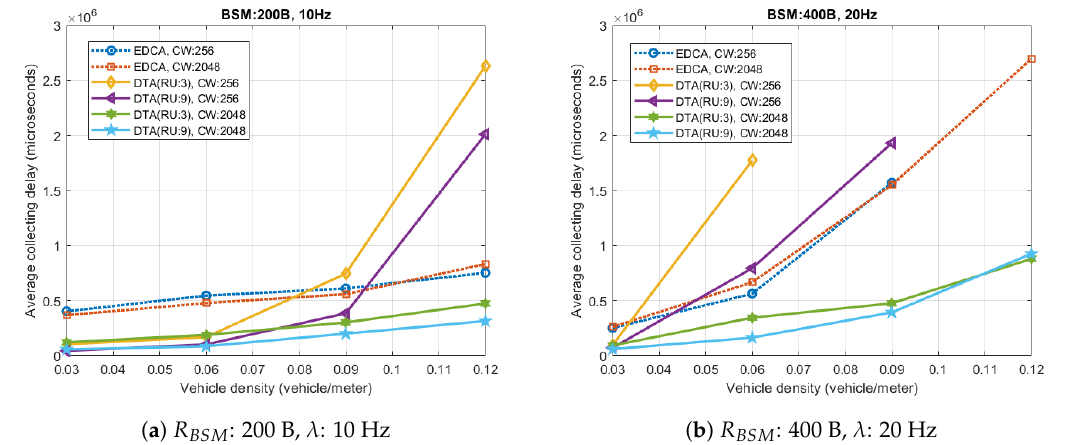
Figure 8. Average BSM collecting